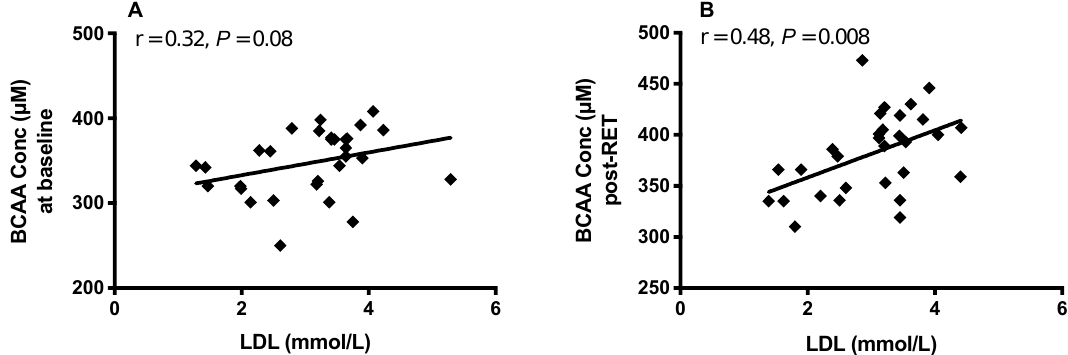
Figure 6. The relationship between circulating BCAA levels and low-density lipoprotein (LDL) before ( A ) and after 20 weeks of fully supervised, whole-body resistance exercise training (RET) ( B ) (n = 32).